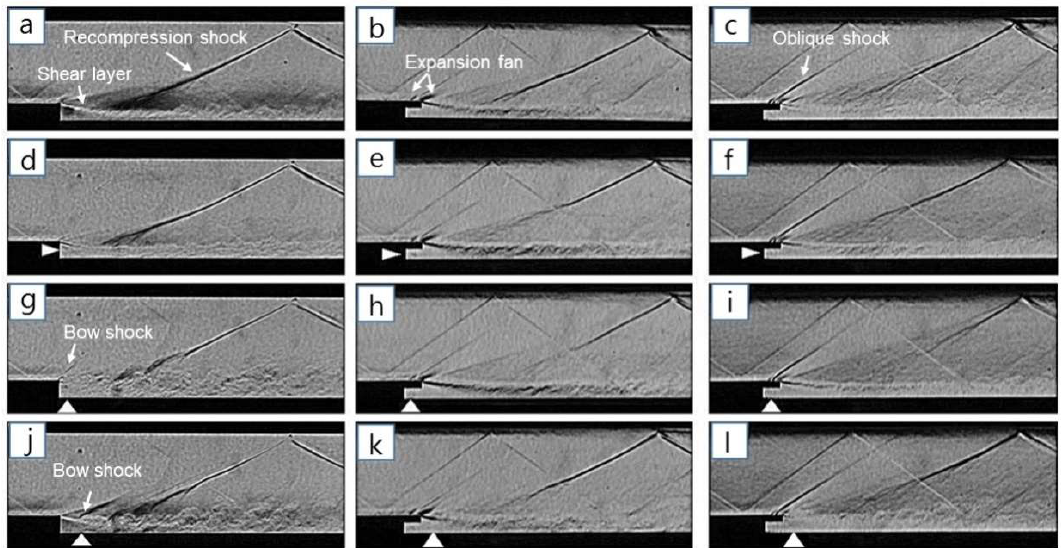
Figure 4. Flow field characteristics with regard to the injection locations for J = 1.6: step mixer ( a , d , g , j ), vent circle mixer ( b , e , h , k ), and vent slot mixer ( c , f , i , l ).